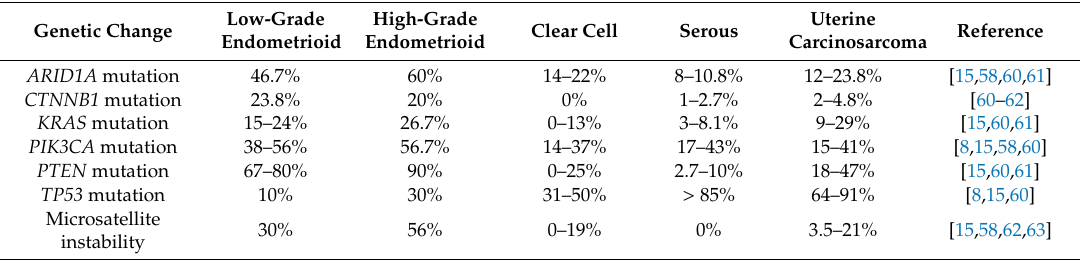
Table 3. Common genetic